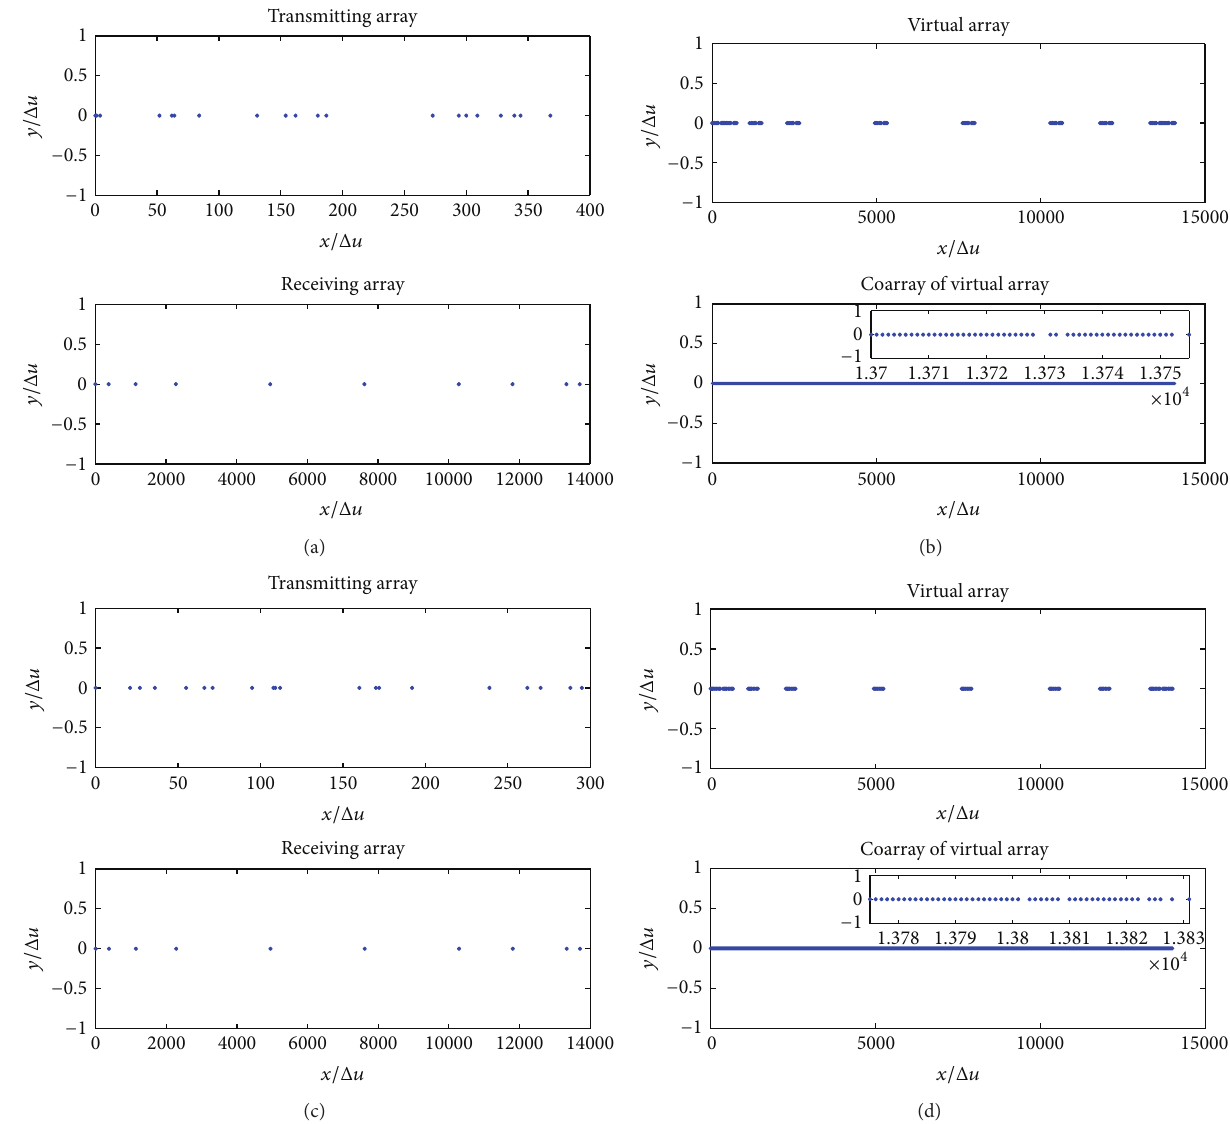
Figure 5: Illustration of a 20 × 10 MR-MIMO array synthesis from the initial CDS (the upper row) and the enumerative shifting procedure (the lower row) (a) and (c) the lattice location of the transmitting and receiving array (b) and (d) the synthesized virtual array and its coarray.